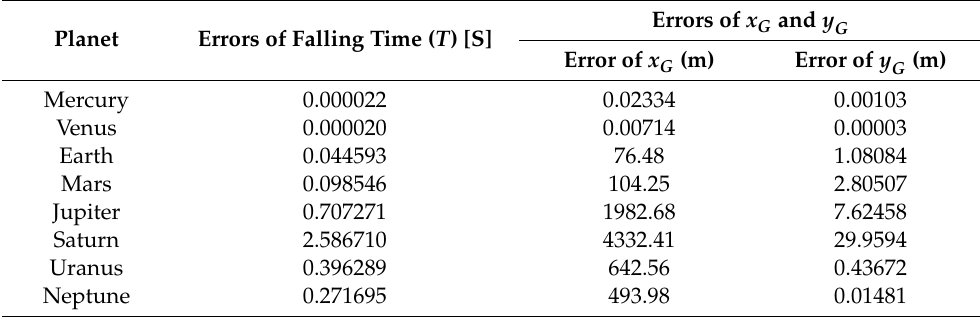
Table 5. The obtained errors of the falling time T , x G , and y G for all planets in the Solar System at the release point Q(50,50,50) (km) when λ = π /6.